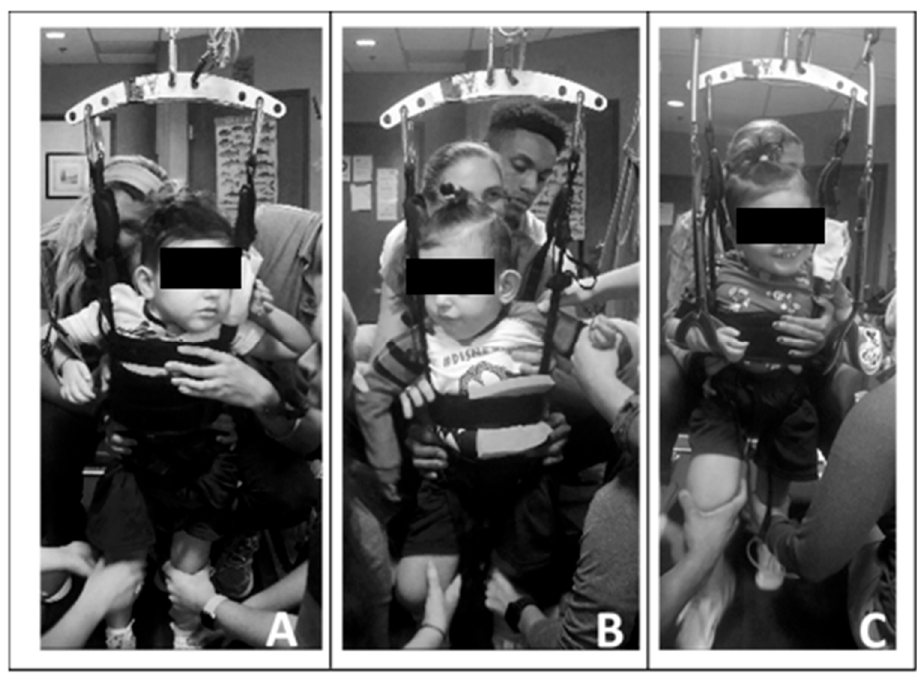
Figure 2. Progress in head and trunk control and engagement across training sessions. ( A ). Session 5, note patient’s use of upright harness strap for a head support. Horizontal trunk strap at height of axillae with manual facilitation providing trunk support. Limited engagement with toys/people. ( B ). Session 24, lowered height of horizontal trunk strap and support, upright and centered head control with visual attention. ( C ). Session 61, consistent upright head and upper thoracic control and initiating activities with his left upper extremity. Engaging with trainers and toys.